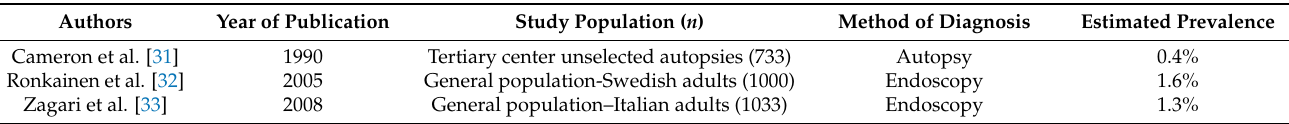
Table 1. Summary of discussed studies estimating Barrett’s Esophagus